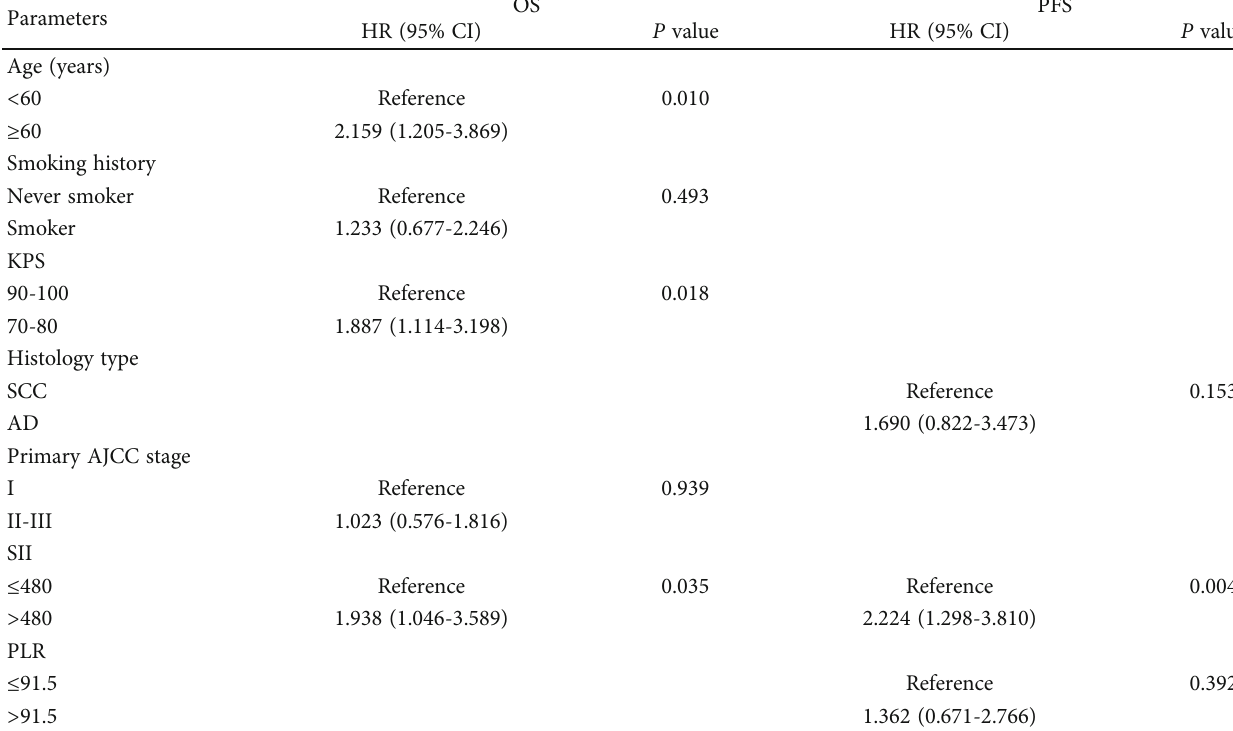
Table 4: Multivariate Cox regression analyses of the SII for OS and PFS in NSCLC patients with